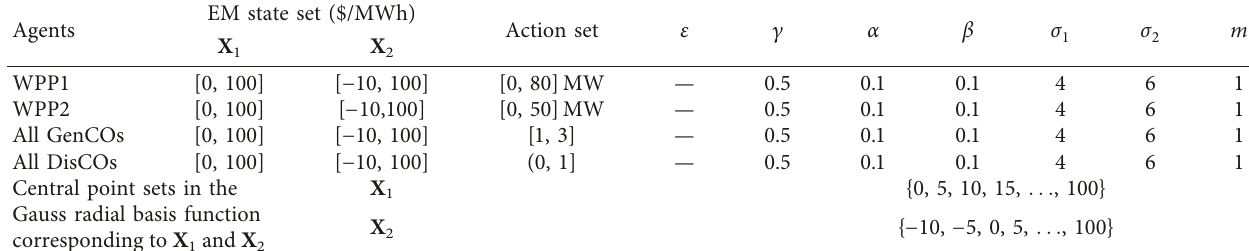
Table 5: Related information about the GDCAC